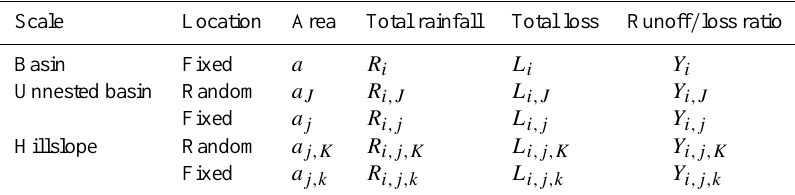
Table 2. Variables that represent random and fixed locations (in space) for area a , total rainfall R , total loss L , and runoff / loss ratio Y . Realizations of R , L , and Y (not shown) are obtained using a lowercase letter; e.g. a realization of R i,j is given by r i,j . Scale Location Area Total rainfall Total loss Runoff / loss ratio Basin Fixed a R i L i Y i Unnested basin Random a J R i,J L i,J Y i,J Fixed a j R i,j L i,j Y i,j Hillslope Random a j,K R i,j,K L i,j,K Y i,j,K Fixed a j,k R i,j,k L i,j,k Y